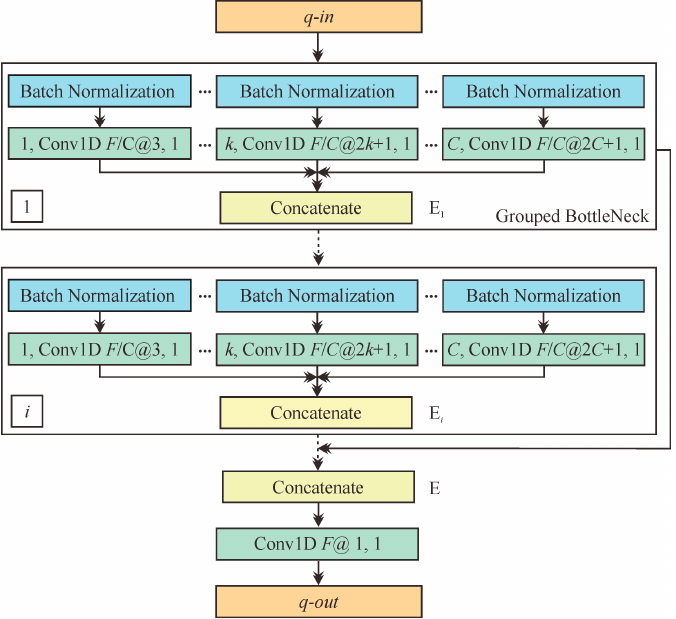
Figure 4. The diagram of the multiscale feature extractor. Where C represents the number of bottleneck blocks.